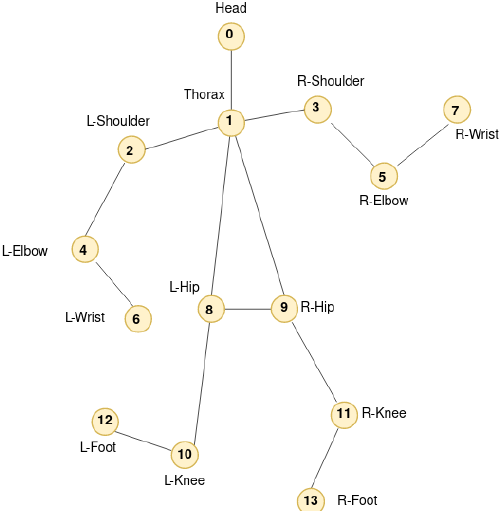
Figure 1. This figure is a non-weighted and undirected graph representation of the human skeleton, with all the selected key-points used for our pedestrian crossing prediction approach. In the present work, only 14 human key-points are chosen from the ones extracted with the Cascaded Pyramid Network (CPN)